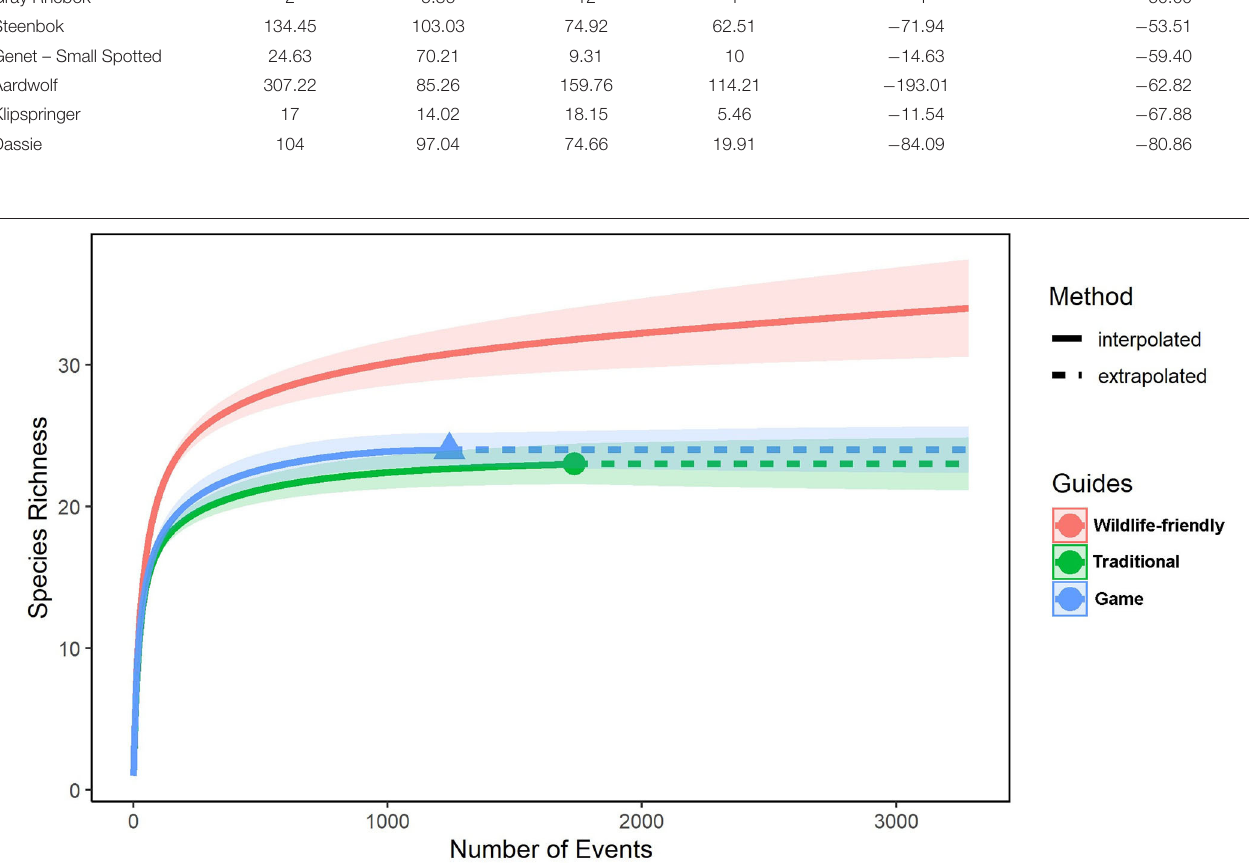
FIGURE 5 | Species accumulation curves for wildlife-friendly, traditional livestock and game farms for 2019, created using the individually corrected camera event histories (RAI values).